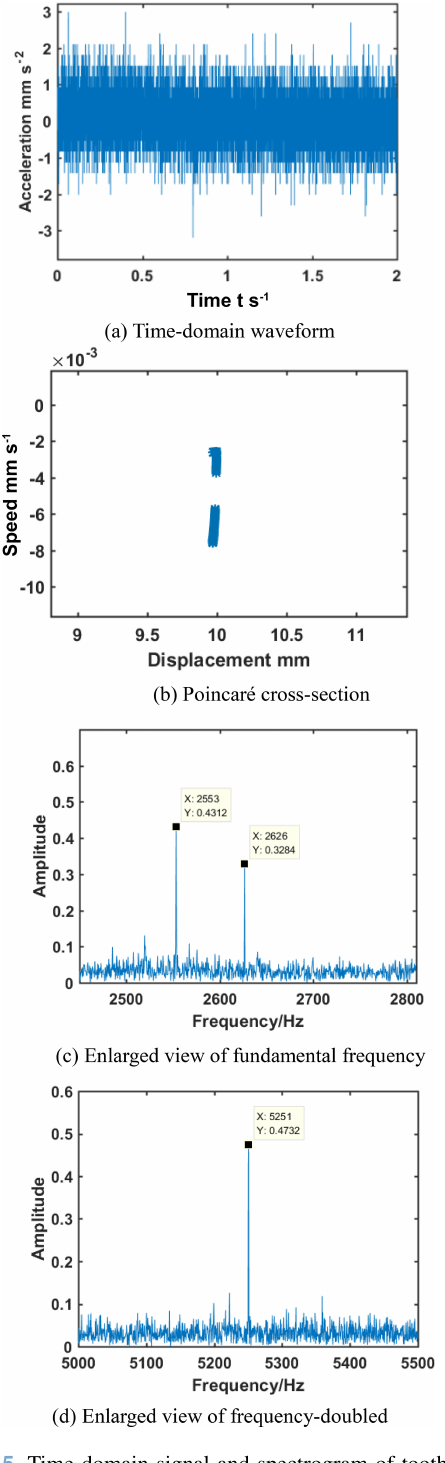
Figure 15. Time-domain signal and spectrogram of tooth surface wear gear at n = 4380rmin − 1